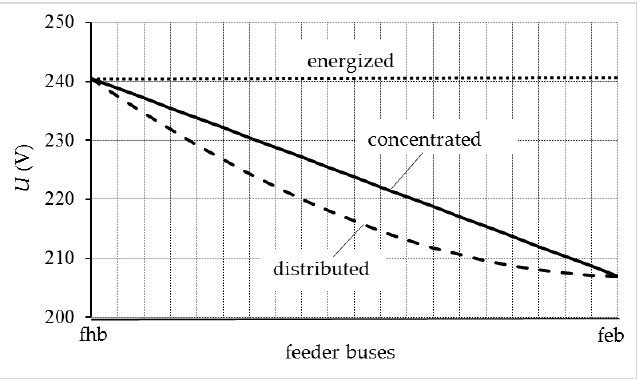
Figure 8. The theoretical voltage profile for the distributed and concentrated var-sink cases.